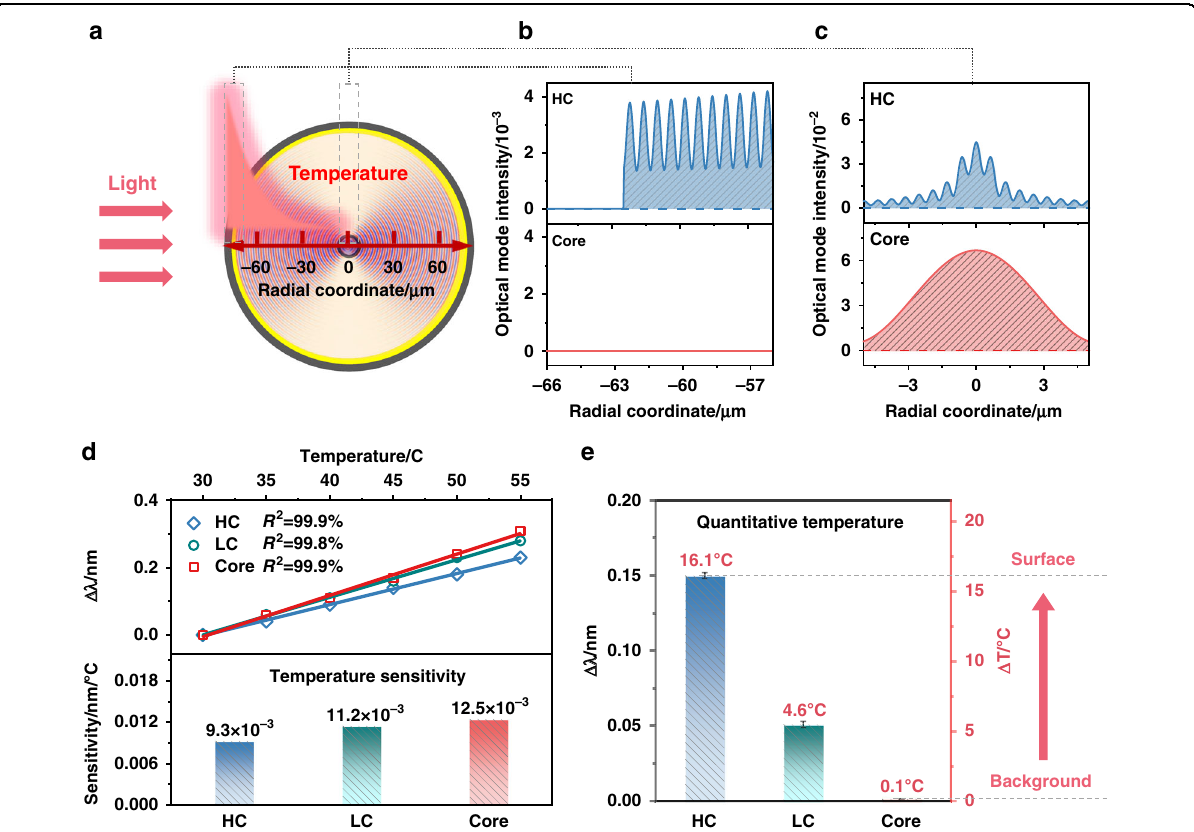
Fig. 4 Operando thermal measurement methodology at the liquid-solid catalyst interface with high spatial and thermal resolutions. a The numerical simulation of mode fi eld distributions in the fi ber cross-section (excited by a TFBG) for light-to-heat measurements and approximate radial temperature distribution. b , c Mode power distributions near the fi ber surface and within the 8.2 μ m diameter fi ber core. d Thermal sensitivity of the HC (99) mode and of the core mode to ambient temperature changes. e Temperature increases at the fi ber surface determined from the wavelength shift of the HC (99), LC (49), and core mode with 1 min of CW laser irradiation, according to the sensitivity obtained from d , and simultaneous observation of no wavelength shift of the core mode resonance. Error bars result from the standard deviation from fi ve